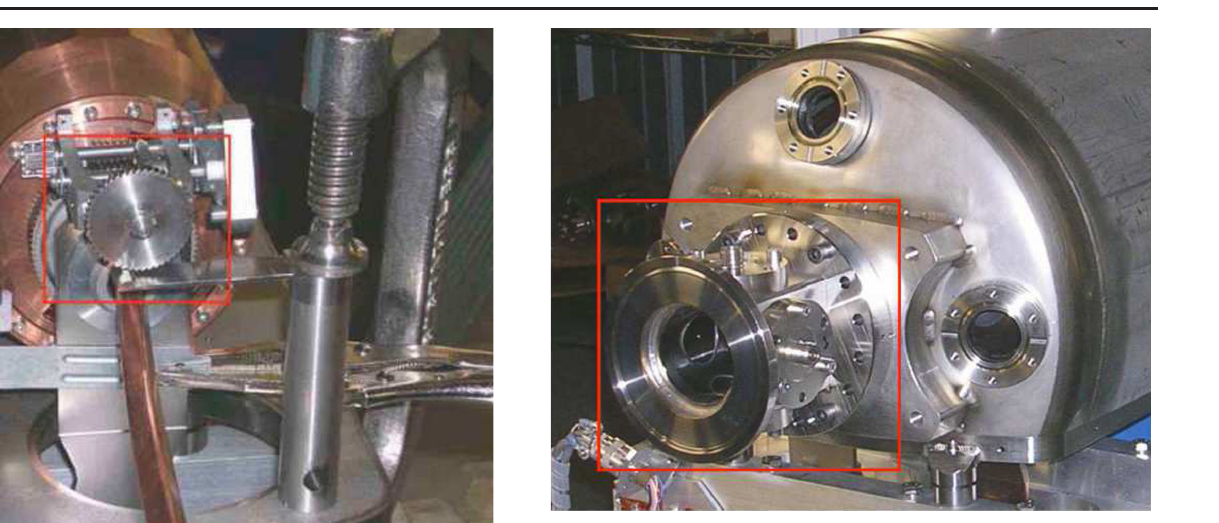
FIG. 4. BPM attached to one side of the prototype collimator tank (inside red